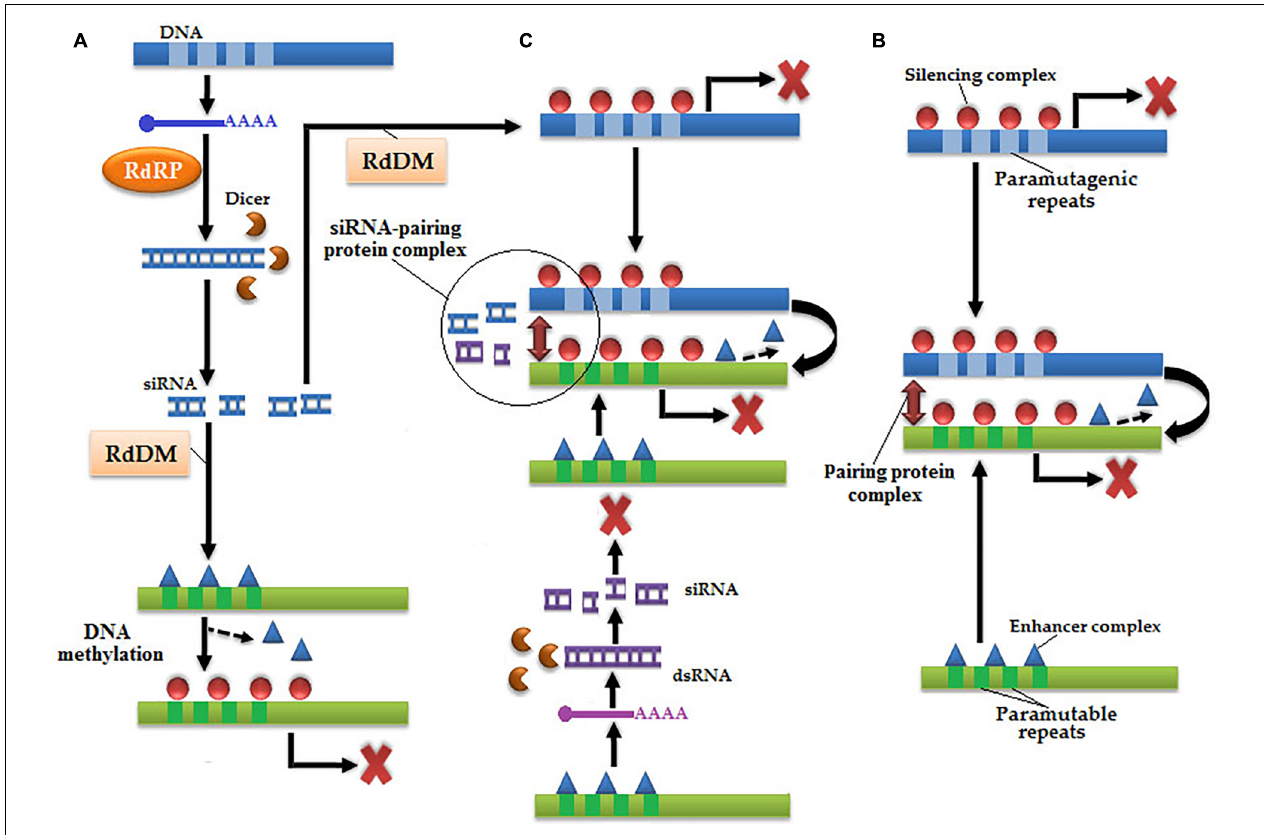
FIGURE 4 | There are three models of paramutation: (A) RNA model, in which paramutagenic repeats of DNA are transcribed into dsRNA under the action of RdRP, which subsequently transformed into siRNA by a Dicer-like protein. Methylation of siRNA occurs via RdDM, which causes chromatin silencing of paramutable repeats by the addition of silencing complex inside enhancer complex resulted in the occurrence of paramutation. (B) Physical interaction, in which both paramutable and paramutagenic repeats physically interact by pairing protein complex and paramutation occurs epigenetically. (C) RNA-physical interaction, which is a combination of both abovementioned models, in which paramutable and paramutagenic repeats transcribed by RaRP into dsRNA, which are subsequently transformed into siRNA by a Dicer-like protein, and only cause chromatin silencing of paramutagenic sequence by RdDM. Subsequently, physical interaction is established via siRNA and pairing protein complex resulted in the modification of paramutable